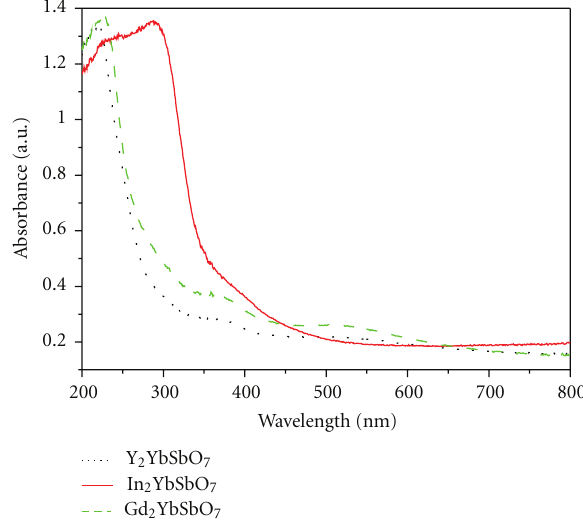
Figure 2: The di ff use reflectance absorption spectra of In 2 YbSbO 7 , Gd 2 YbSbO 7 , and Y 2 YbSbO 7 .